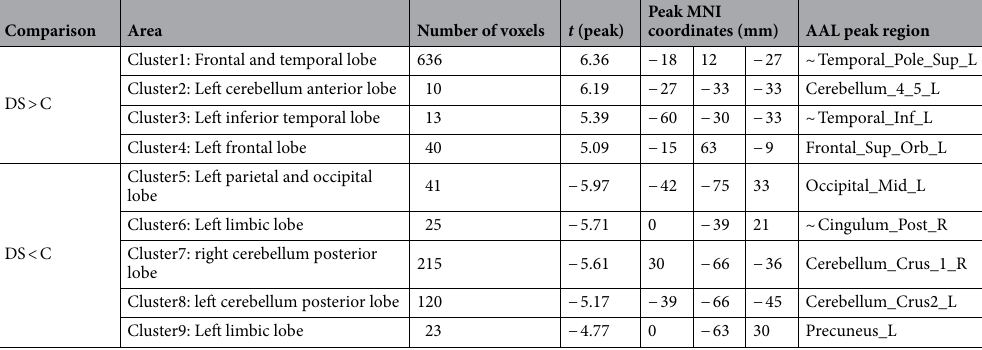
Table 2. Significant between-group differences in fALFF. C: Controls; MNI: Montreal Neurological Institute; ~ : approximately, AAL atlas area closer to the t peak.